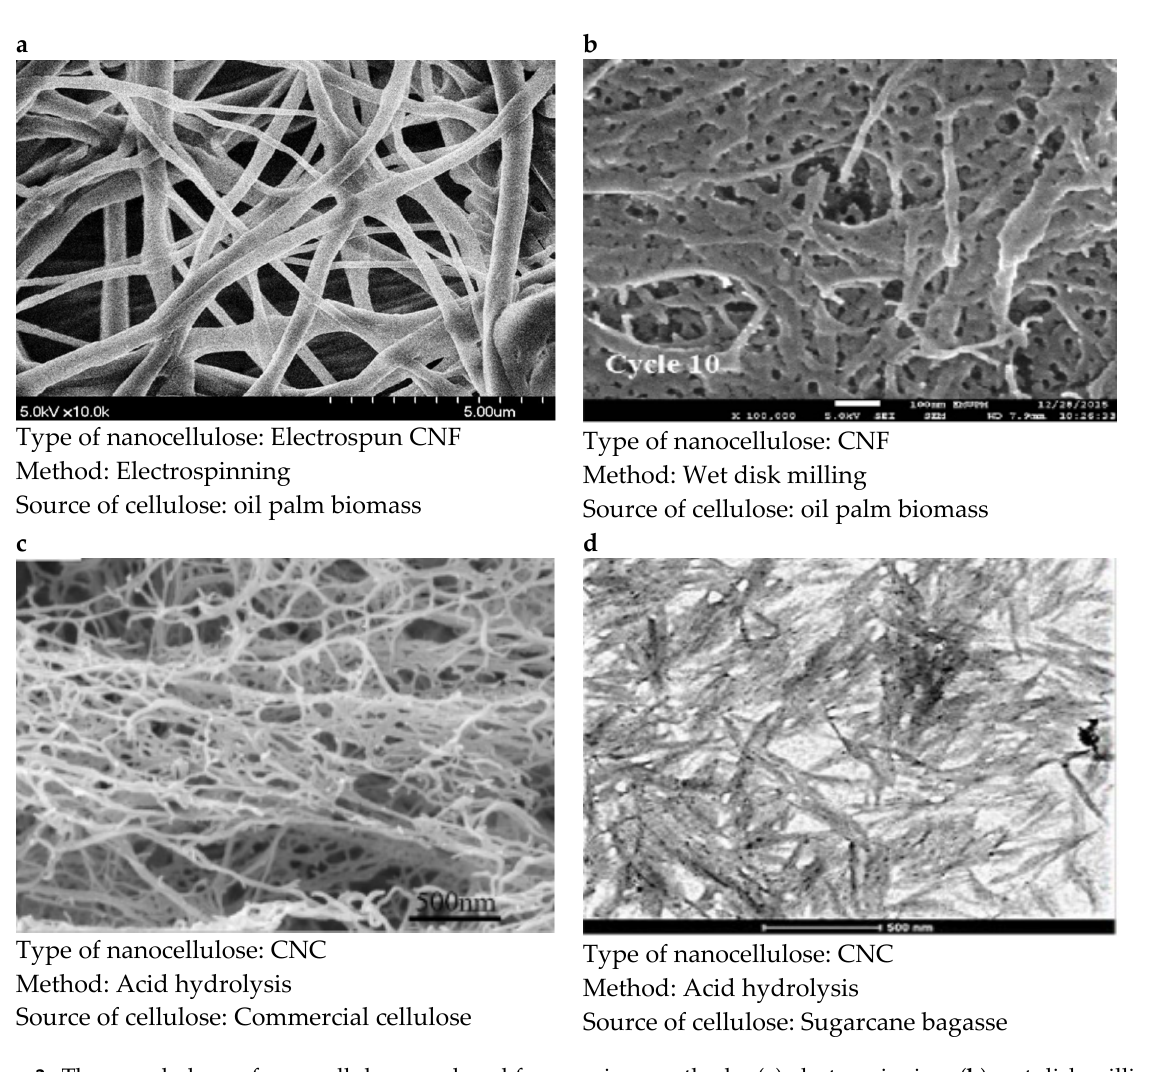
Figure 3. The morphology of nanocellulose produced from various methods. ( a ) electrospinning, ( b ) wet disk milling, ( c , d ) acid hydrolysis. This figure is adapted with permission from the [49–52].